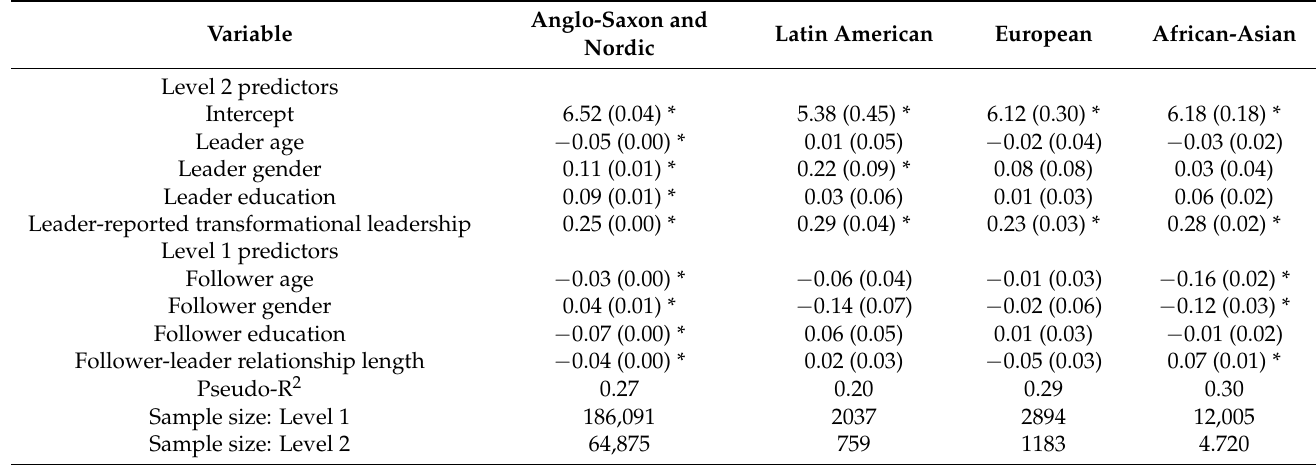
Table 2. Multilevel models of cultural-comparative leadership perception a